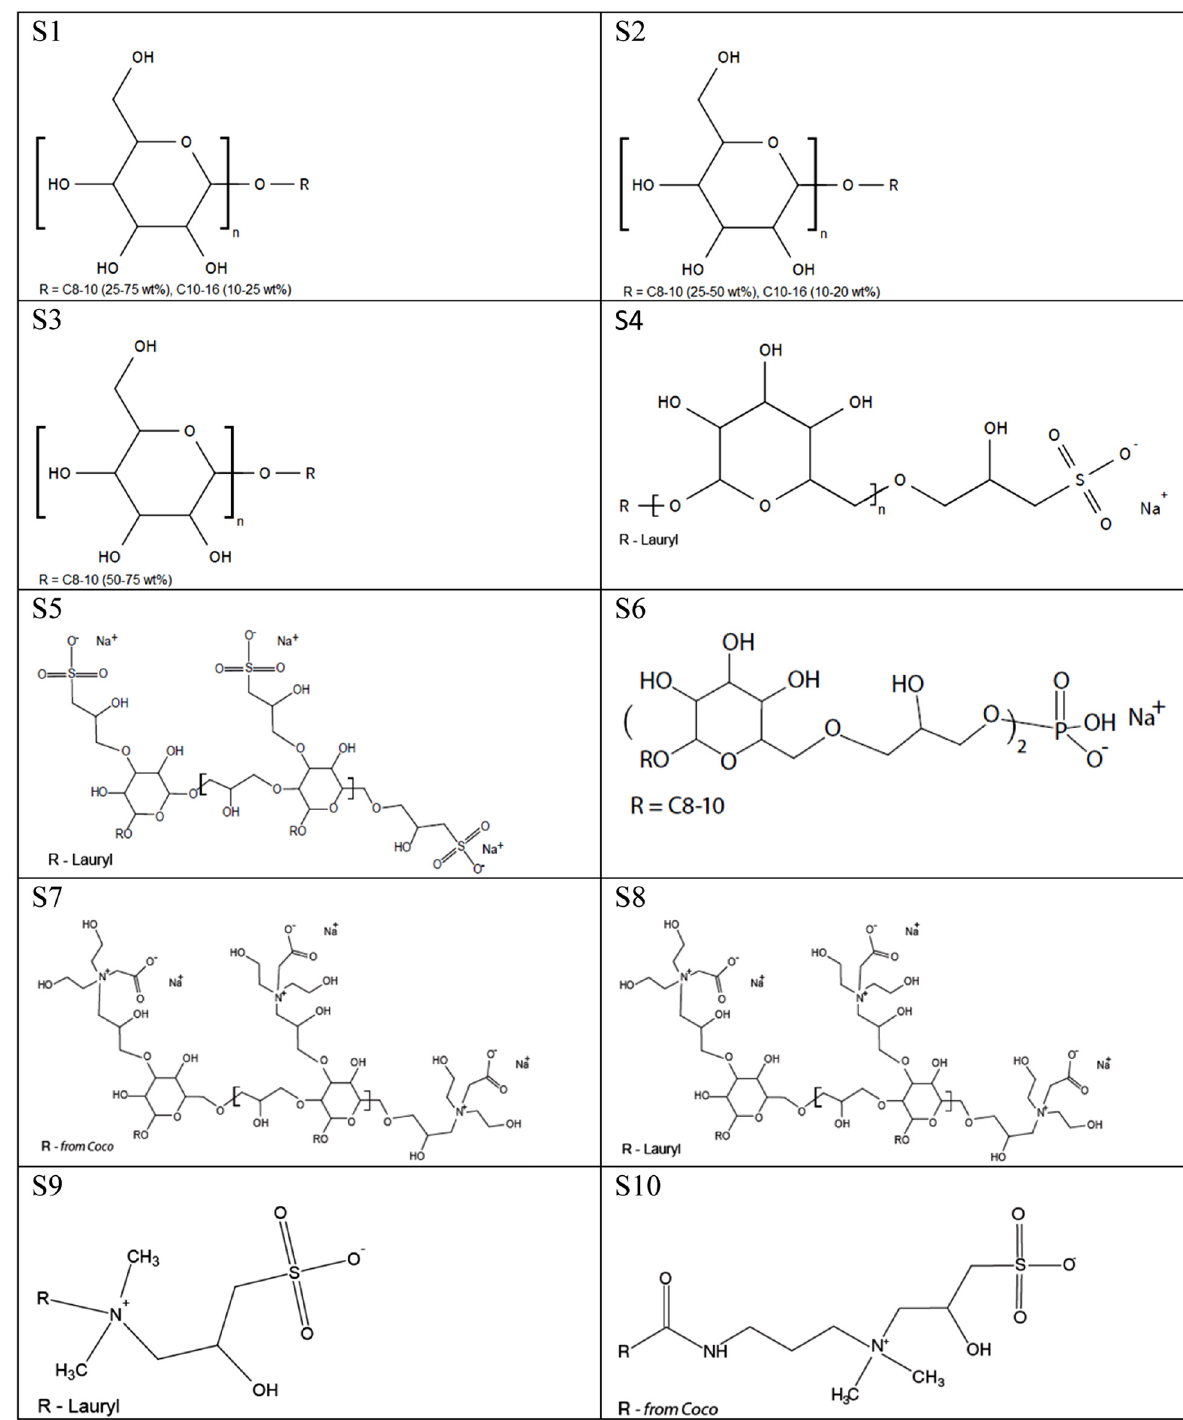
Figure 1: Molecular structure of studied